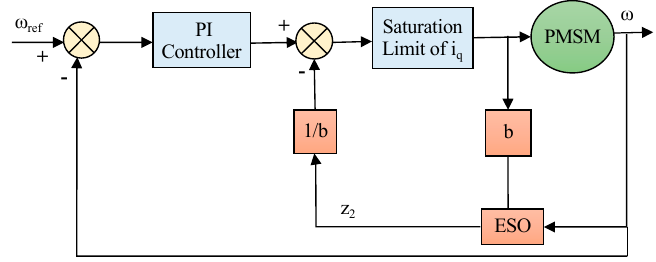
Figure 9. Basic structure of the PMSM ESO control.